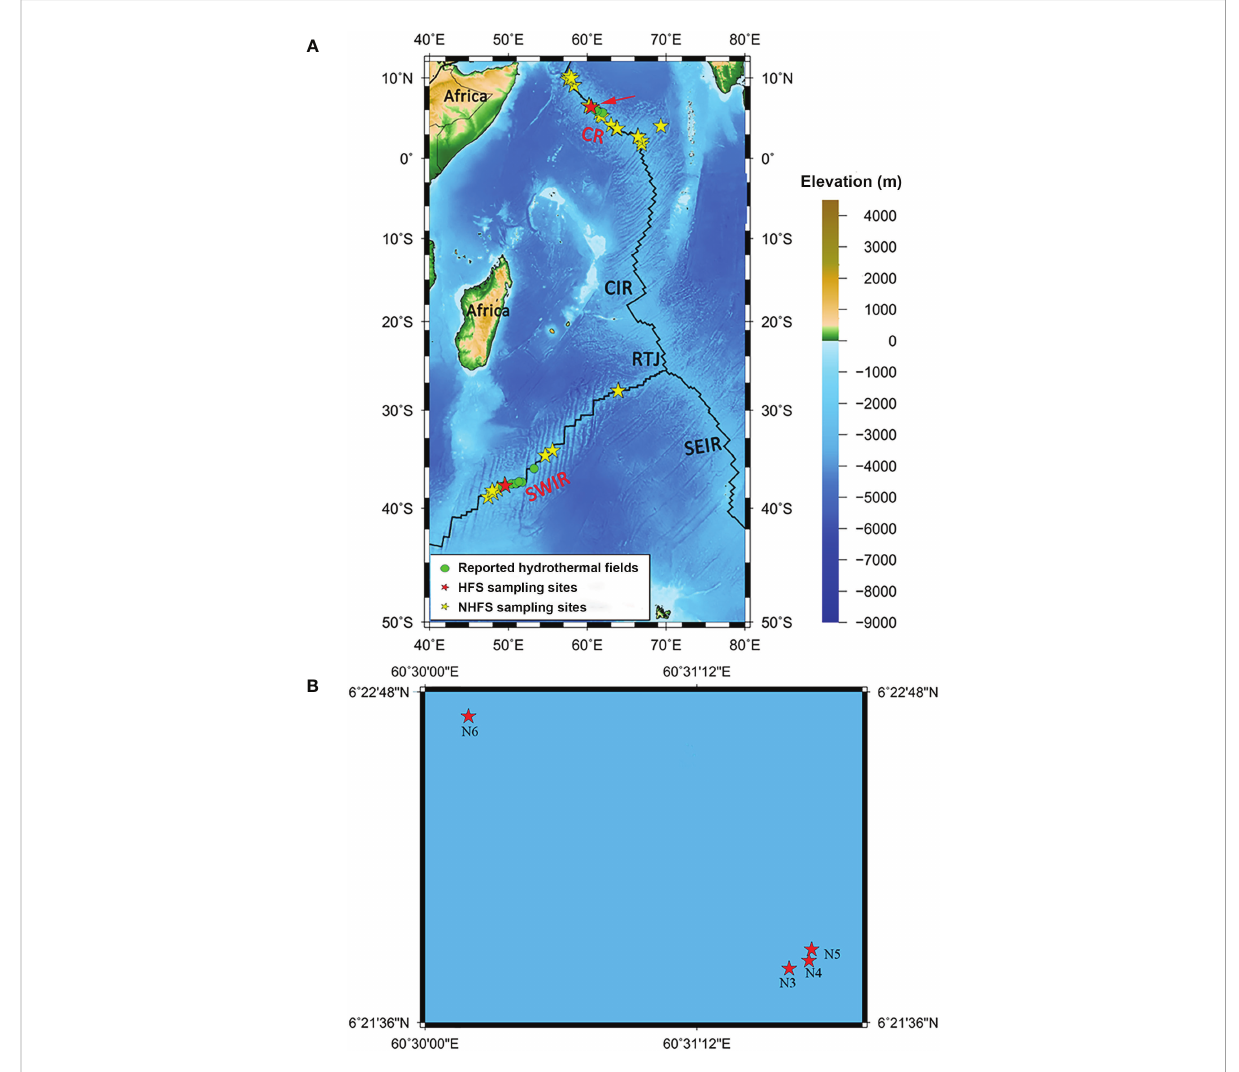
FIGURE 1 The map of sampling locations in this study. (A) The whole 39 sampling sites on the Southwest Indian Ridge (SWIR) and the Carlsberg Ridge (CR). (B) Magni fi ed view of the sampling area of CR marked by a red arrow in A, where N3-N5 were from the hydrothermal fi eld Wocan-1 and N6 from Wocan-2. Green dots indicate the hydrothermal fi elds from previous studies (Tao et al., 2012; Tao et al., 2013; Tao et al., 2014). Red and yellow stars indicate the sampling sites of hydrothermal fi eld sediments (HFSs) and non-hydrothermal fi eld sediments (NHFSs), respectively. SEIR, Southeast Indian Ridge; CIR, Central Indian Ridge; RTJ, Rodrigues Triple Junction (25.5°S,